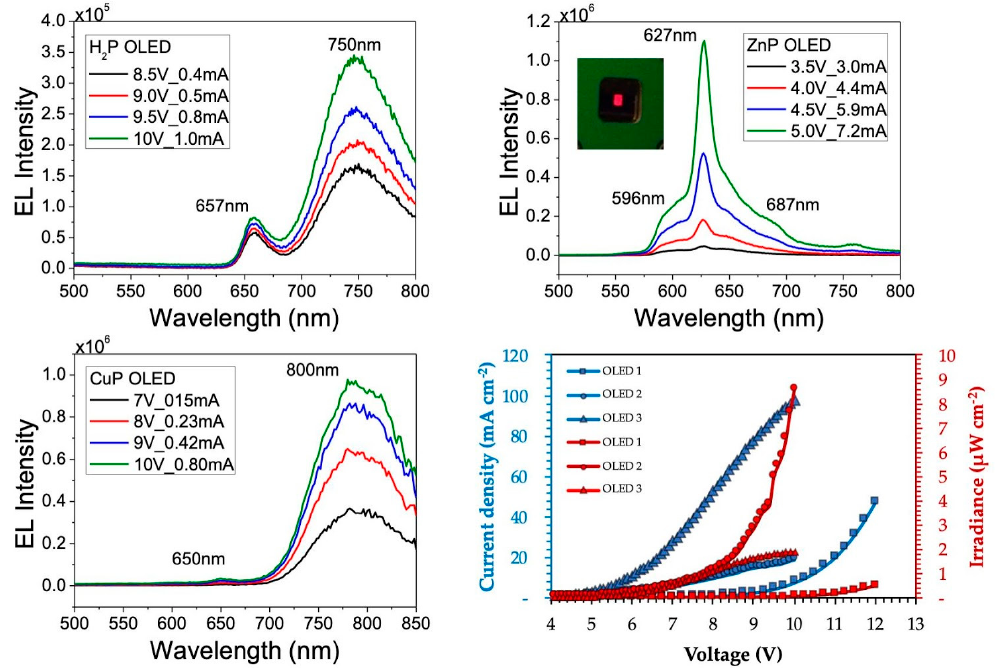
Figure 7. Electroluminescence spectra and the irradiance and current density curves for the devices OLED-1 (H 2 P), OLED-2 (ZnP), and OLED-3 (CuP).